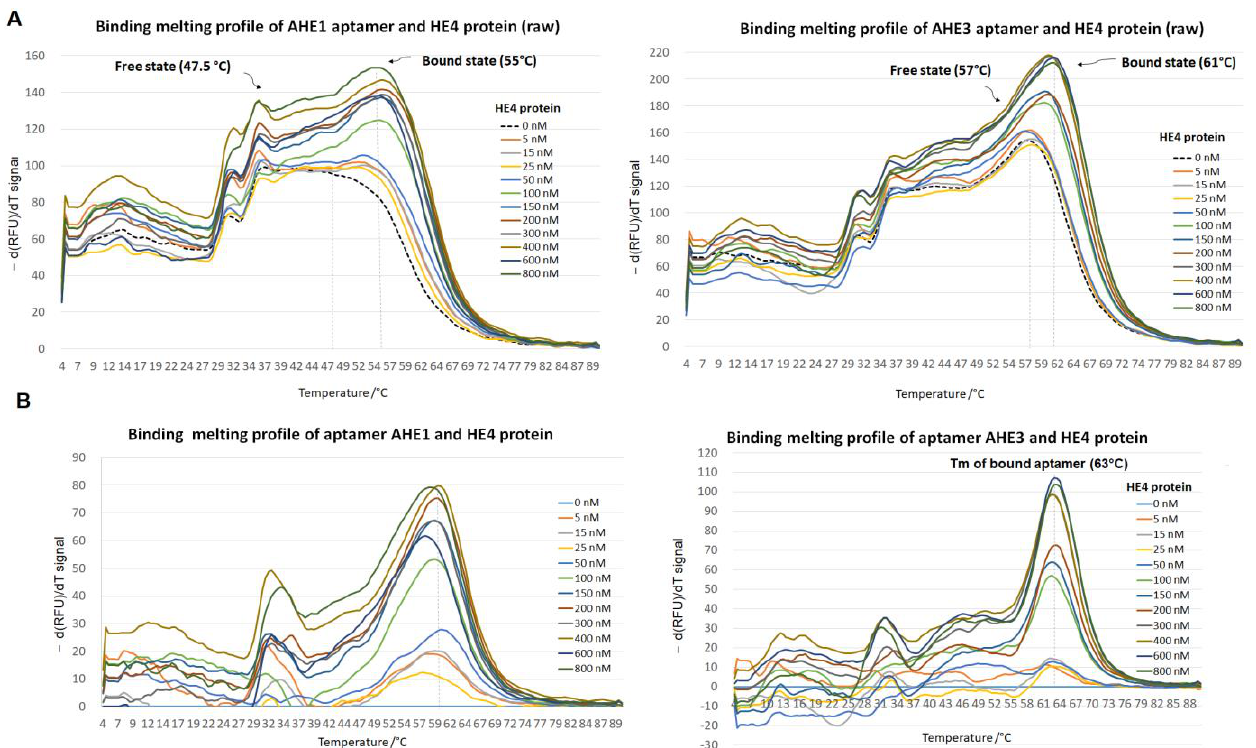
Figure 6. Thermofluorimetic analysis of the anti-HE4 aptamer binding to ovarian cancer biomarker HE4 in urine. The constant aptamer concentration of 100 nM was subjected to an increasing concentration of HE4 protein in urine ranging from 0 to 800 nM. The melting profile was analyzed from 4 °C to 90 °C. The binding thermal curves (melting DNA profile) were constructed by plotting temperature with negative derivative fluorescent signal − d(RFU)/dT. The results showed the average of the minimum 3 independent experiments. ( A ) The raw melting profile. The raw melting profile obtained for aptamers showed two distant peaks corresponding to free aptamer (no HE4) state and bound aptamer state (with HE4 protein). Upon binding to HE4 protein, more thermally stable species were present, with a shift to higher T m . ( B ) The melting profile after subtraction of signal from aptamer only. After subtraction of the blank (aptamer only, no HE4), peaks of the aptamers bound to HE4 were visible, with a shift to higher T m values, corresponding to 60 °C for AHE1 and 63 °C for AHE3, suggesting binding to target protein HE4.